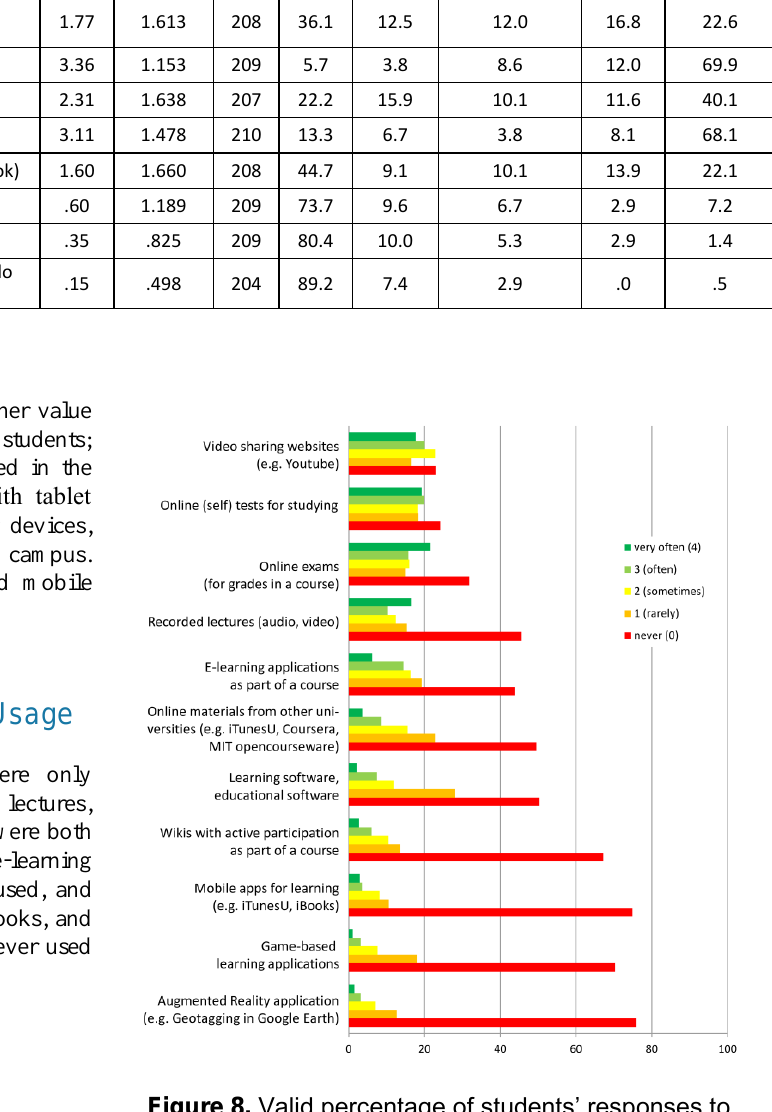
Figure 8. Valid percentage of students’ responses to the question: How often do you use the following for